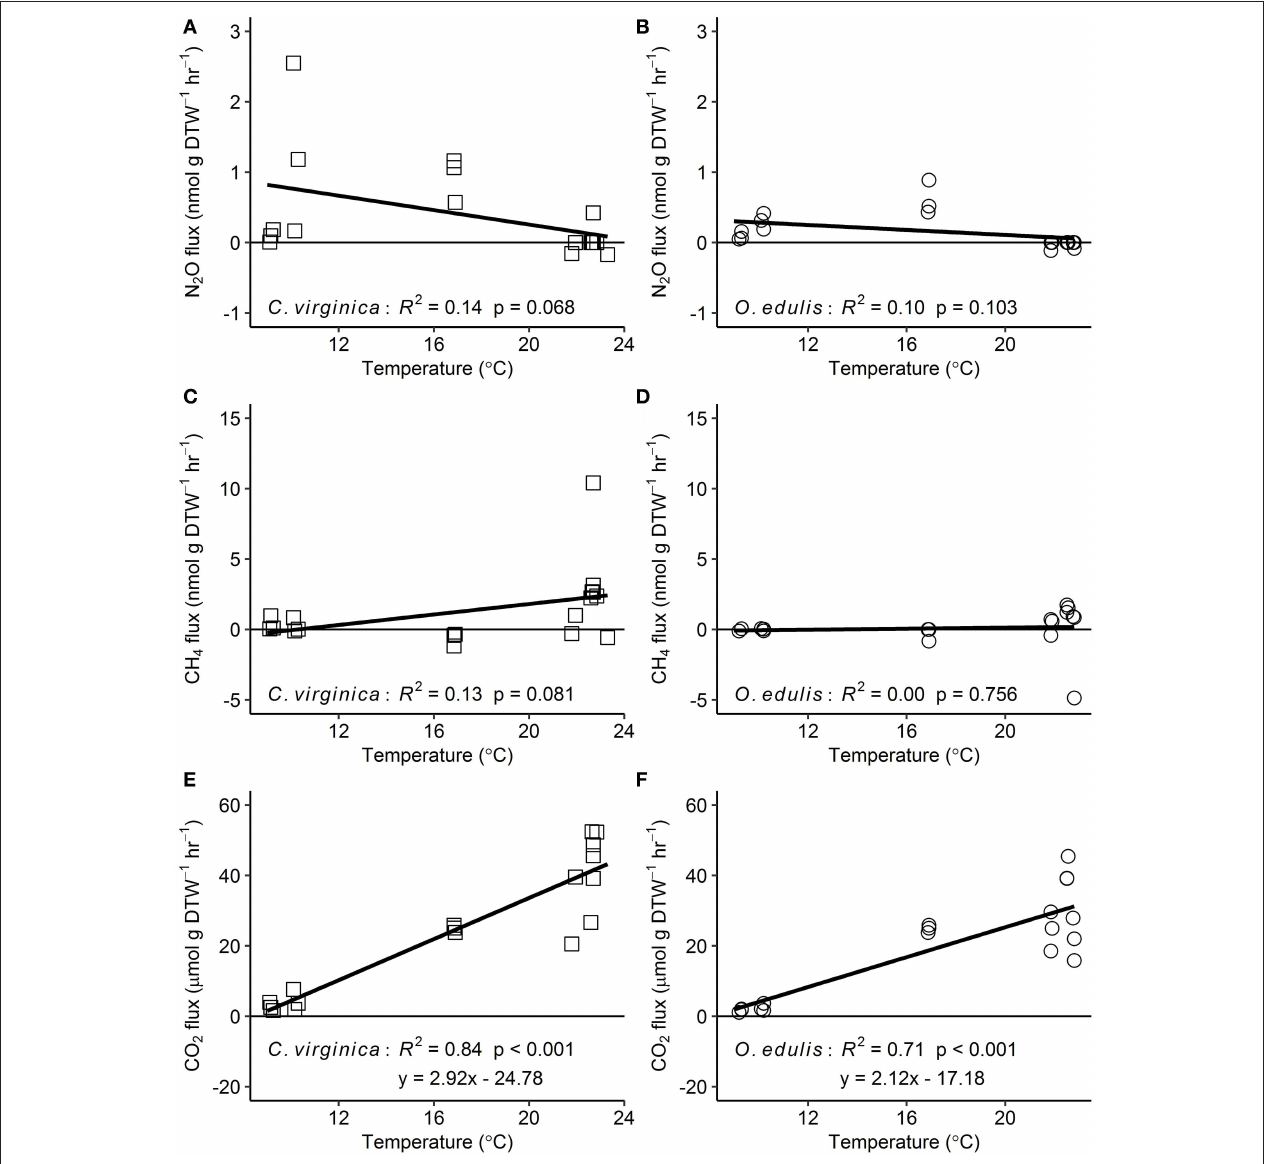
FIGURE 2 | Relationships between temperature and nitrous oxide (A,B) , methane (C,D) , and carbon dioxide (E,F) fluxes for native ( C. virginica : open squares) and non-native oysters ( O. edulis : open circles); n = 18 for each species and flux, except n = 17 for C. virginica CO 2 fluxes. R 2 and p -values from linear regressions. Points below the zero-line show net consumption, and points above show net